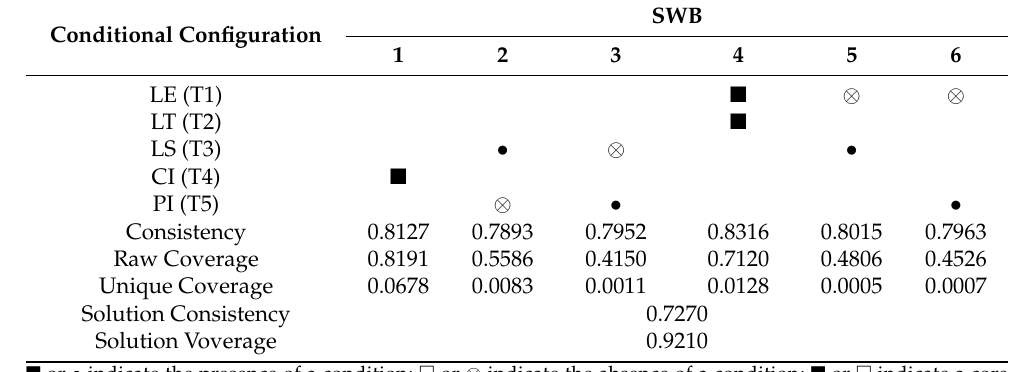
Table 10. The results of the conditional configuration